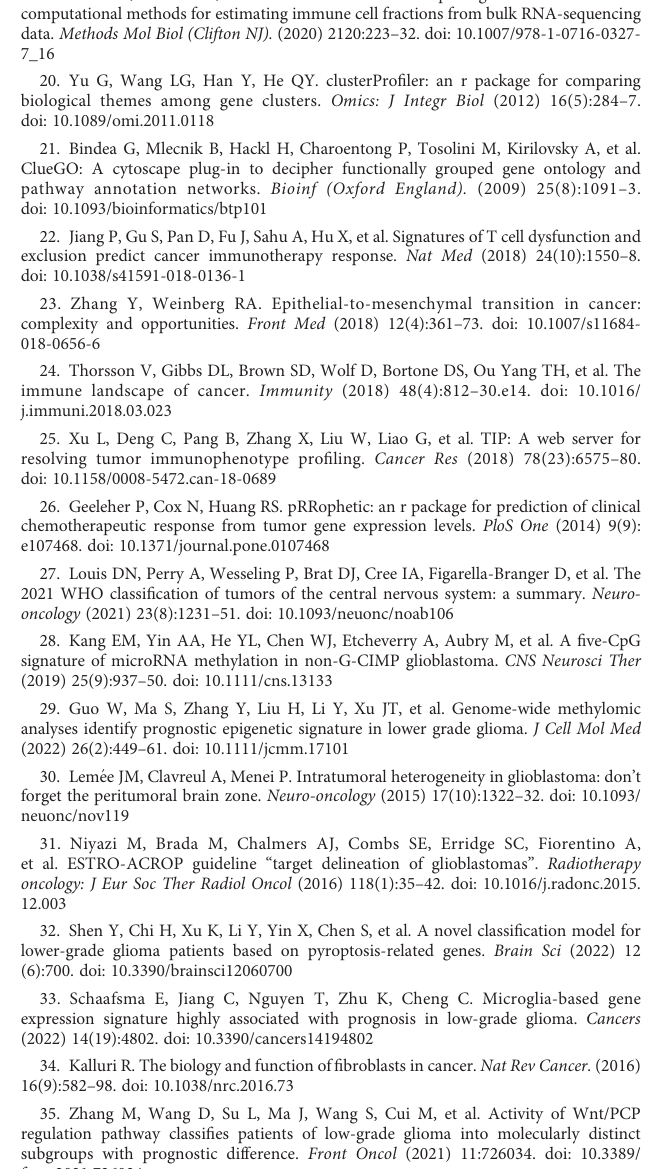
SUPPLEMENTARY TABLE 6 The formula of calculate risk